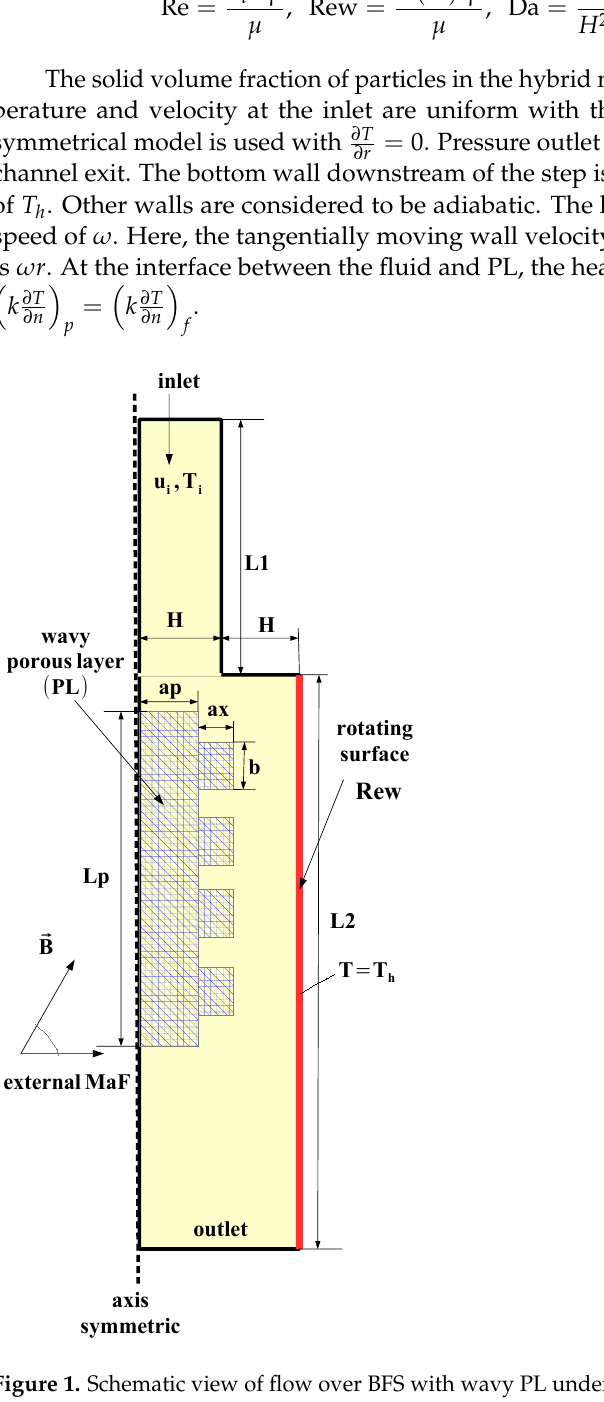
Figure 1. Schematic view of flow over BFS with wavy PL under coupled effects of rotations and